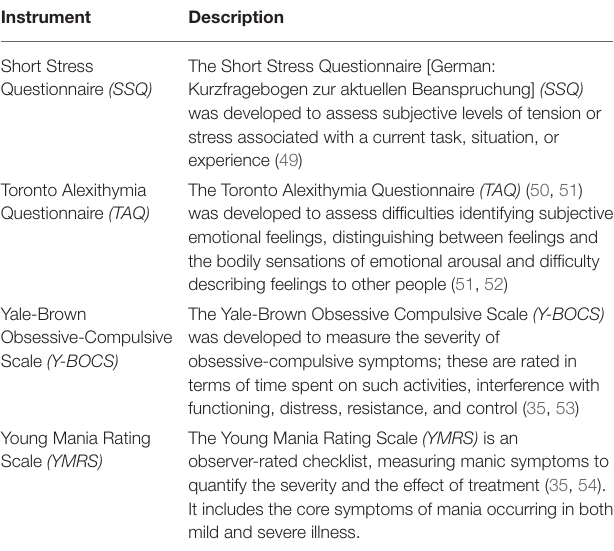
TABLE 2 | Psychometric measurement instruments included in the Test Battery used in the